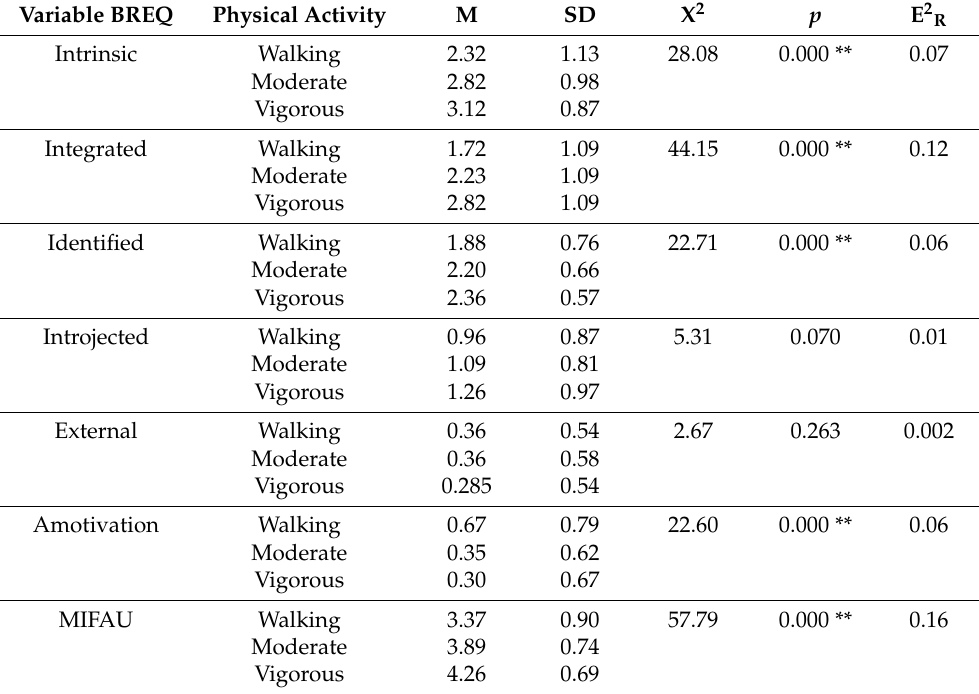
Table 5. Regulation of motivation and intention to engage in PA according to the PA